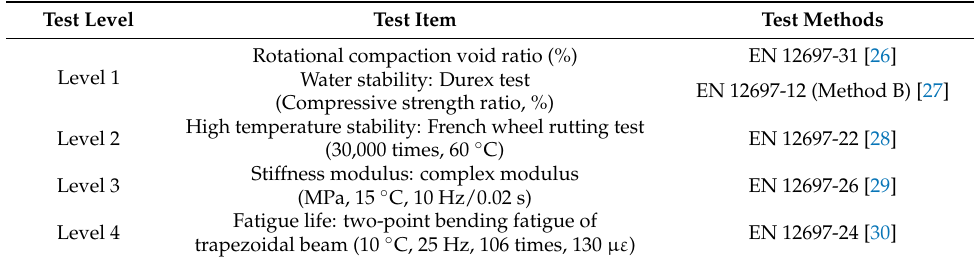
Table 6. High-modulus mixture performance index verification test plan.